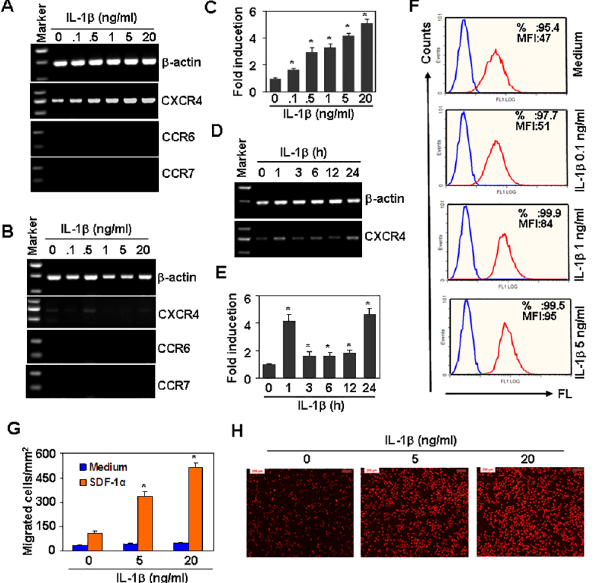
Fig 2. IL-1 β up-regulates CXCR4 expression. (A&B) The effect of IL-1 β on the mRNA expression of chemokine receptors in Tca8113 (A) and Hep2 (B) cells. Cells were treated with 20 ng/ml IL-1 β for 24 h. The mRNA levels of CXCR4, CCR6 and CCR7 were measured by RT-PCR. β -actin mRNA levels were measured as loading controls. (C) Quantitative CXCR4 mRNA expression in (A). * P < 0.05 compared with the non- treated group. (D) Time course of CXCR4 mRNA expression in response to IL-1 β stimulation. Tca8113 cells were treated with 20 ng/ml IL-1 β for the indicated time periods. The mRNA levels of CXCR4 were detected by RT-PCR. β -actin mRNA levels were measured as loading controls. (E) The quantitative data corresponding to (D). * P < 0.05 compared with the non-treated group. (F) The effect of IL-1 β on CXCR4 protein expression. Tca8113 cells were treated with the indicated concentrations of IL-1 β for 24 h. CXCR4 protein expression was detected by FACS. (G) The effect of IL-1 β on SDF-1 α -induced cell migration. Tca8113 cells were treated with the indicated concentrations of IL-1 β for 24 h. Cell migration in response to medium or 20 ng/ml SDF-1 α was measured by the Transwell assay. * P < 0.05 compared with control groups. (I) The transwell assay showed cell migration in response to 20 ng/ml SDF-1 α after treatment with the indicated concentrations of IL- 1 β for 24 h (Scale bars: 200 μ